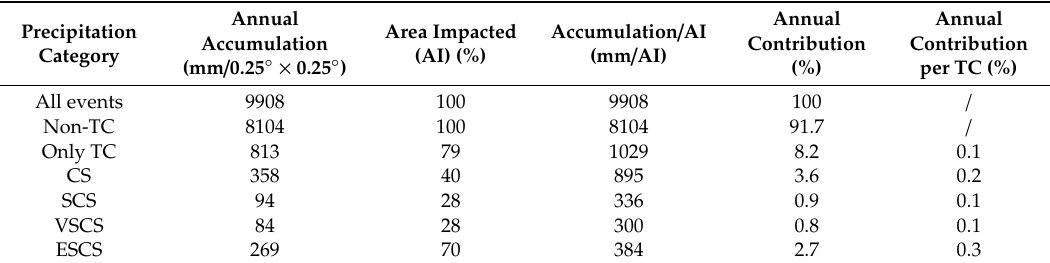
Table 1. January-December (1998–2016) rainfall characteristics overland for all rainfall events, non-TC rainfall, TC rainfall, and TCs intensity groups’ rainfall. Rainfall characteristics are divided into 4 categories: annual accumulation overland (mm), area impacted (%), accumulation / area impacted (mm), and the annual contribution